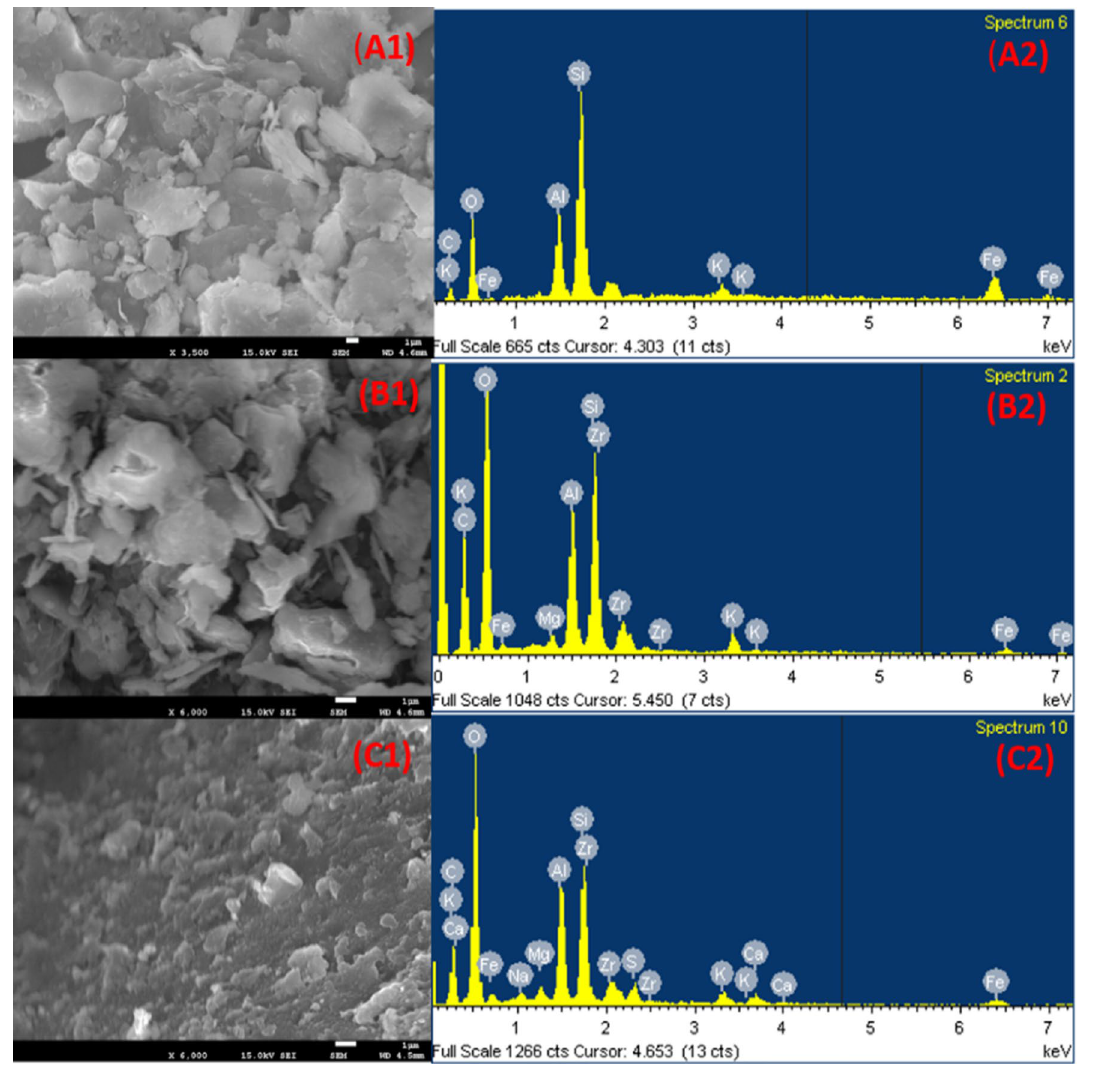
Fig. 5 FE-SEM images and associated EDS spectra of soil specimen collected from different rivers. A Dawki, B Surma and C Burigana soil